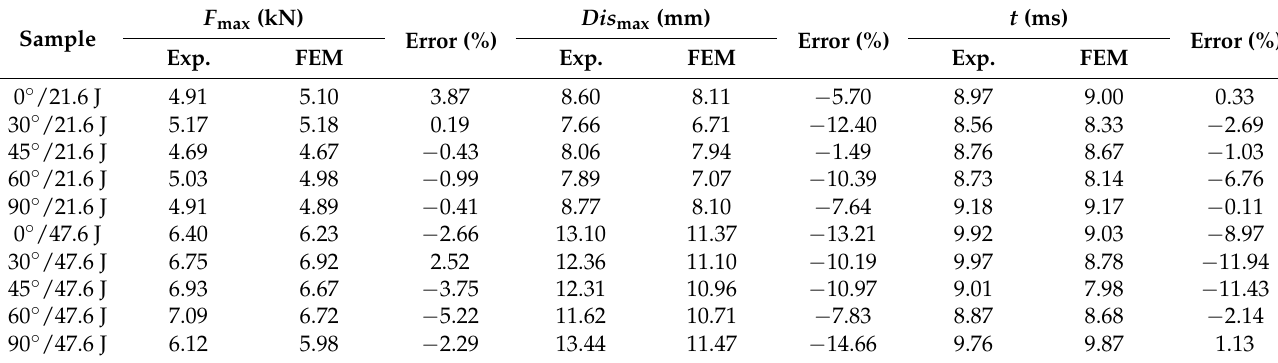
Figure 3. Force-time relations under 47.6 J of impact energy. Figure 3 . Force-time relations under 47.6 J of impact energy. Table 3. Comparison of numerical and experimental Table 3 . Comparison of numerical and experimental results.